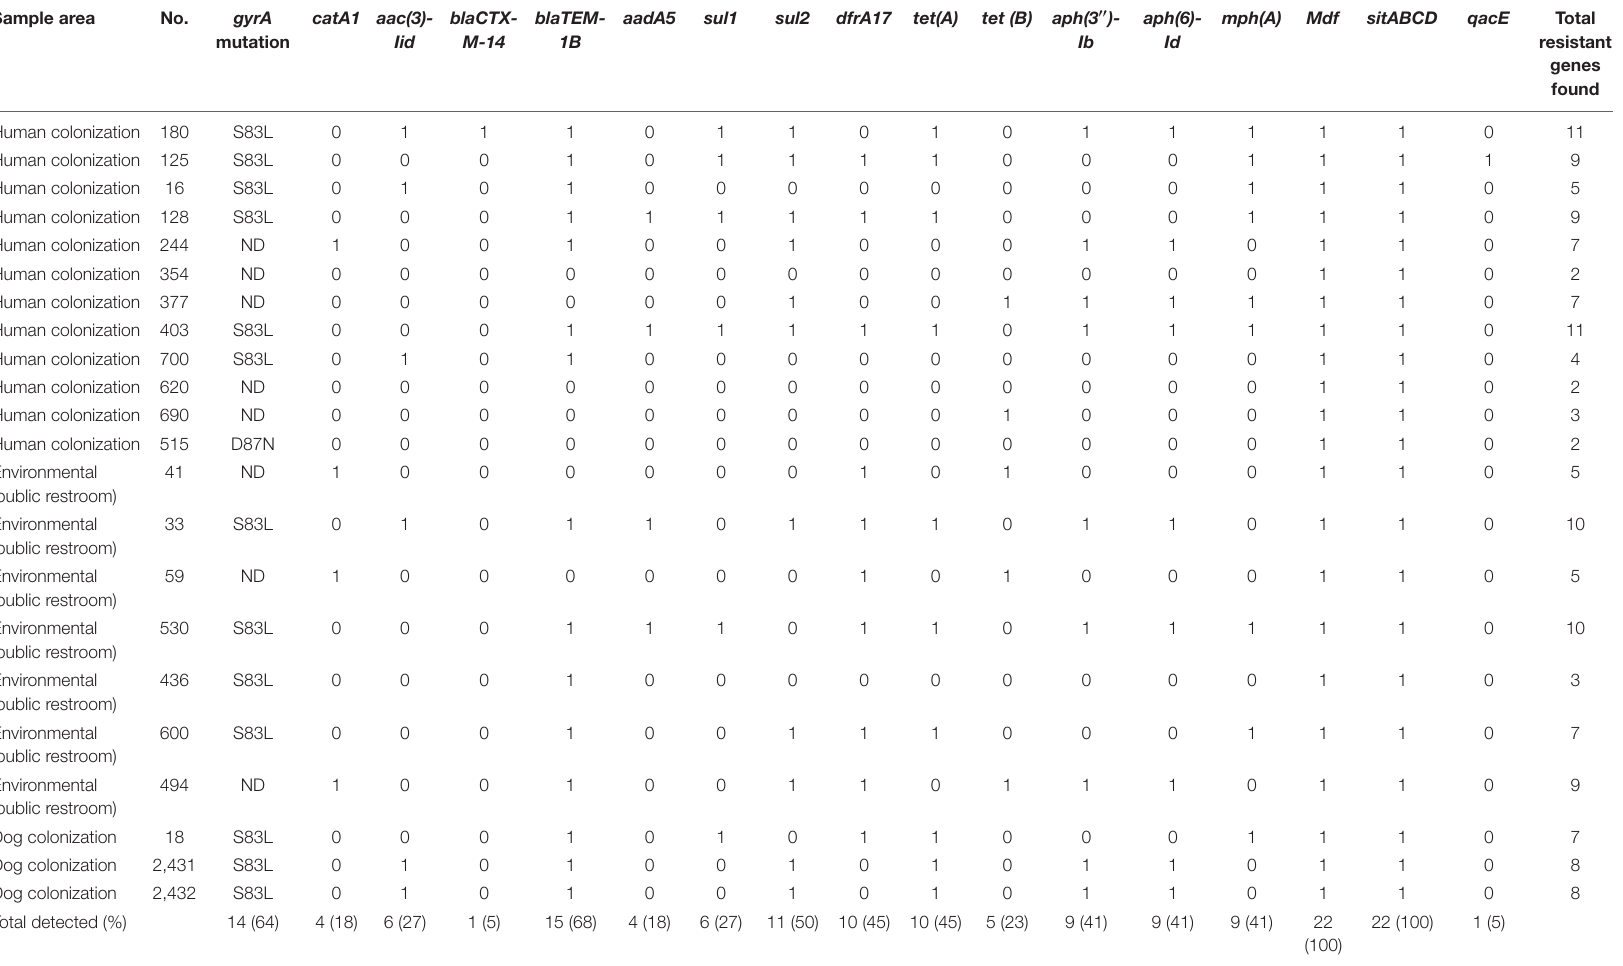
TABLE 4 | Acquired resistance genes and associated point mutations detected in 22 isolates of ST131 Escherichia coli with fimH41. Sample